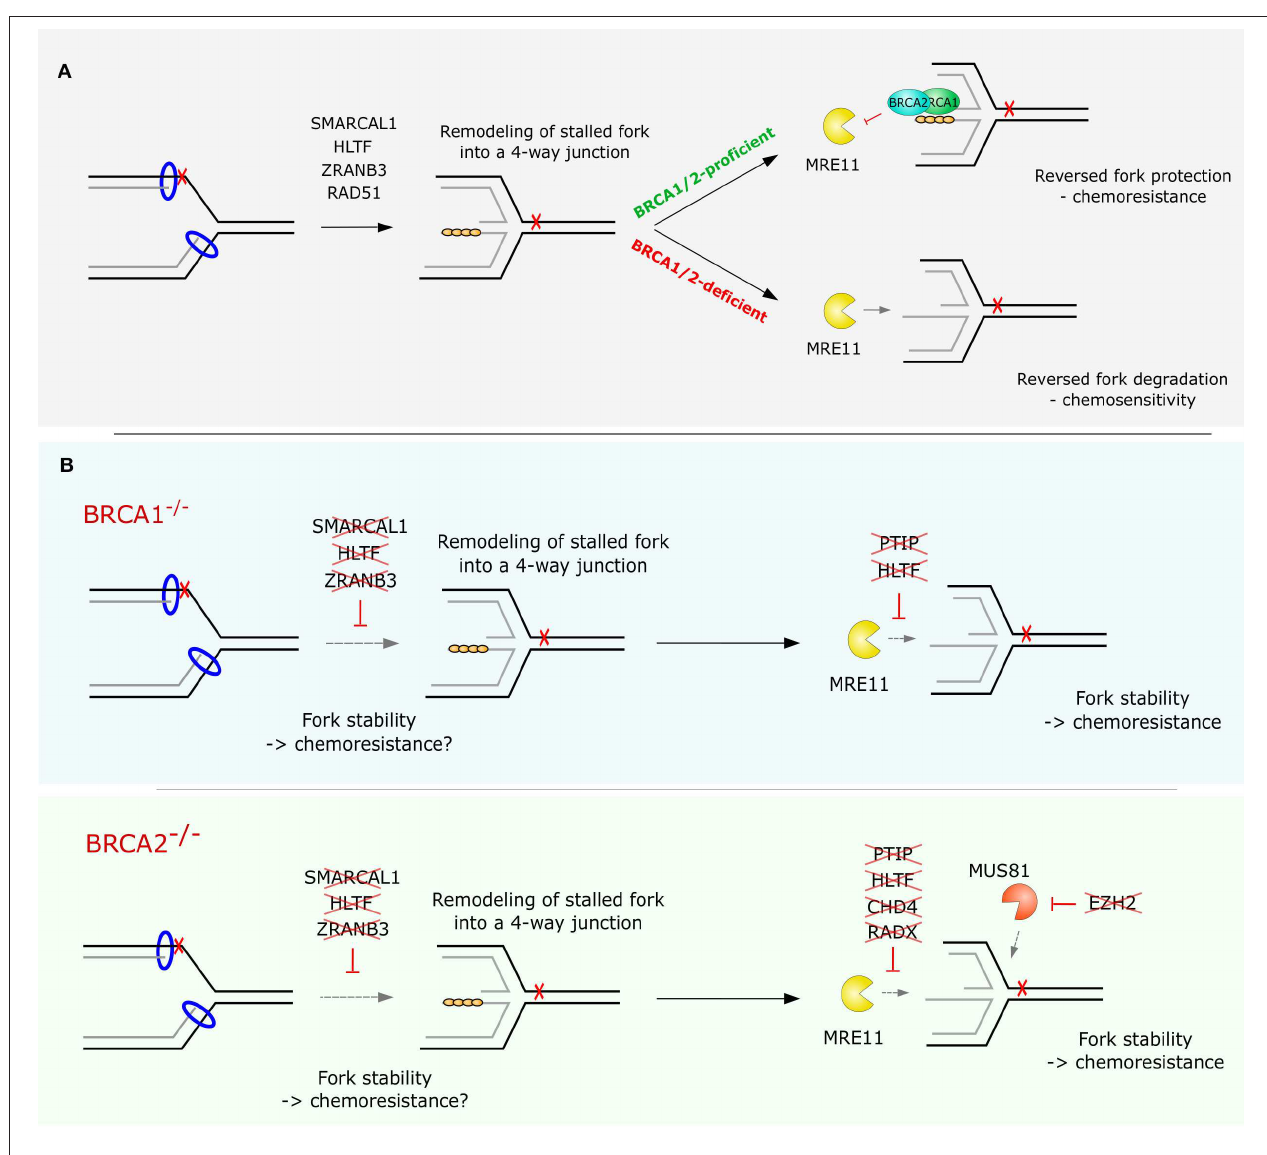
FIGURE 3 | Replication fork stability or degradation in BRCA1/2-proficient and -deficient cells. (A) Reversed replication fork arms are protected from degradation by RAD51 nucleofilaments stabilized by BRCA1 and BRCA2. In the absence of BRCA1/2 proteins RAD51 dissociates from ssDNA at the regressed arms, leaving the nascent DNA susceptible to nucleolytic resection by exonucleases such as MRE11. (B) Overview of the factors shown to restore RF stability and confer chemoresistance upon their loss in BRCA1- or BRCA2-deficient